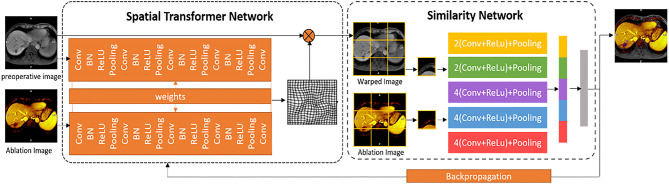
The non-rigid DIR STS-net. Two neural network (left: spatial transformer network and right: similarity network). The orange frame is a non-rigid transformation parameter generation framework in which there are three parts: The localization network specified by a Siamese network, grid generator, and sampler. The blue frame is a similarity calculation framework where the deep multiscale features from the transformed pre-operative image and ablation image are extracted by a convolutional neural network, and their similarity is backpropagated to the orange frame for more accurate registration.